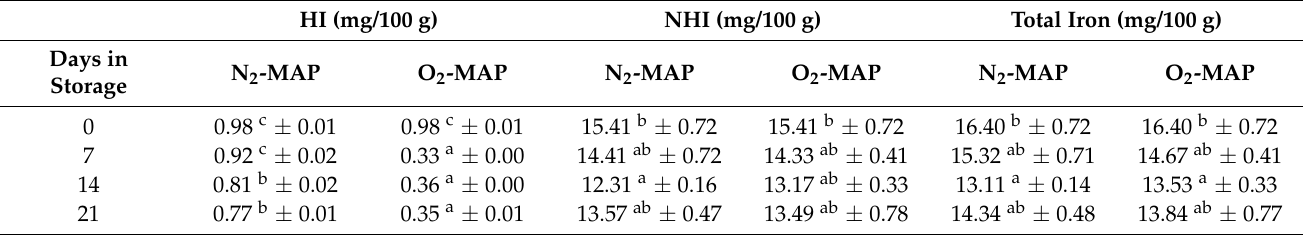
Table 6. Effect of form (‘cookie’ or ‘flower’), time in storage and MAP on the different forms of iron measured in the 3D-printed products form